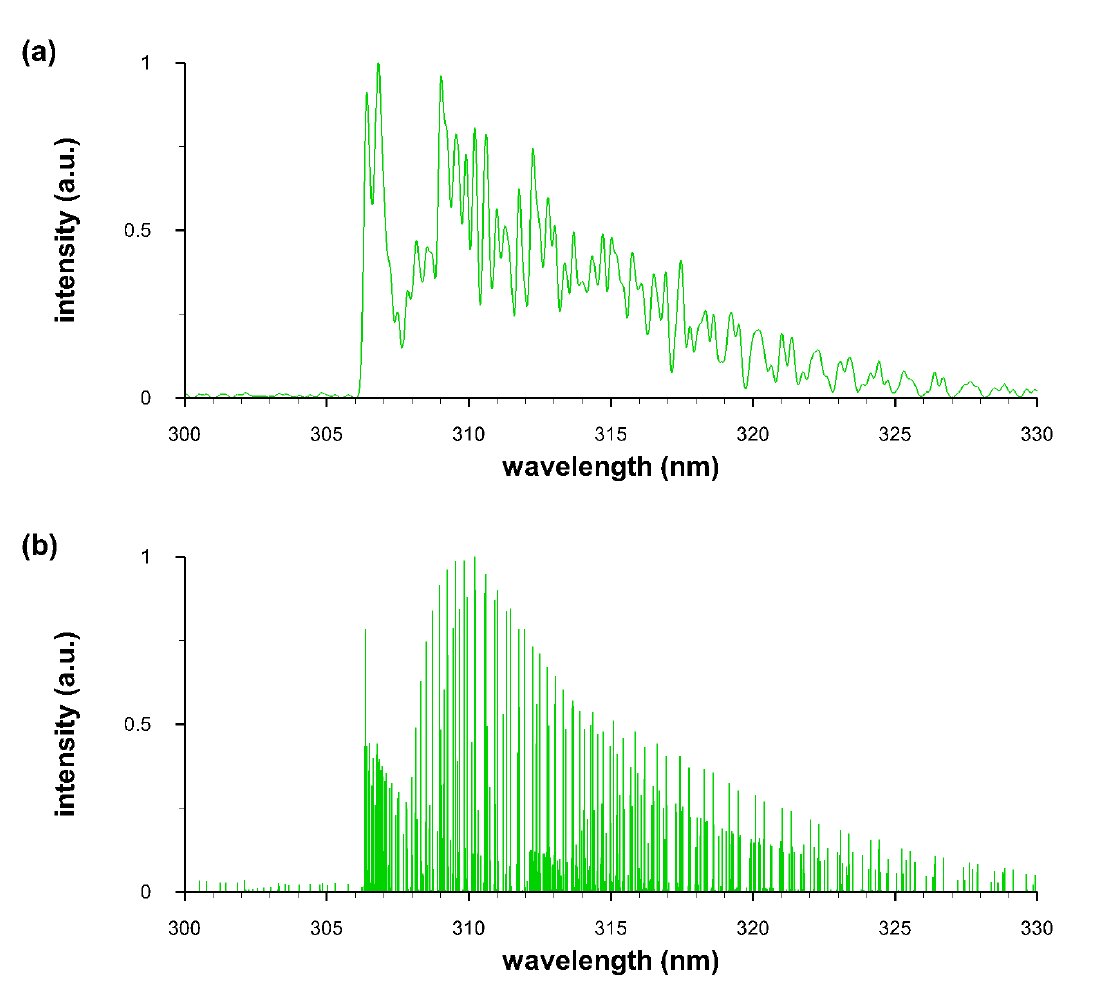
Figure 7. Computed spectra: T = 6000 K; spectral resolution ( a ) 0.25nm and ( b )